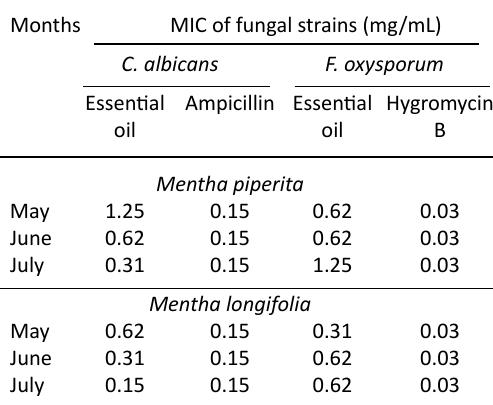
Table 7. MIC values of M. piperita and M. longifolia leaves essential oil against C. albicans and F.